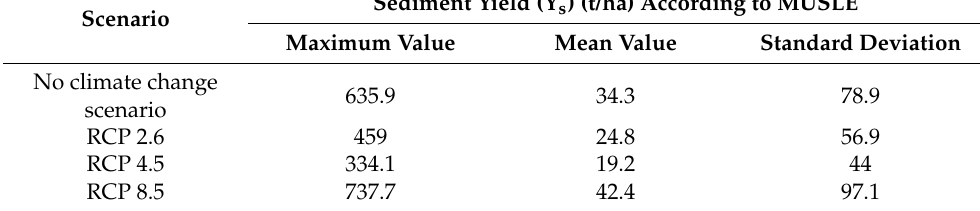
Table 8. Results of the statistical trend of the data obtained by the application of the MUSLE model (4 September 2011 rainfall event) to the Guerna catchment, considering different climate scenarios (where AMC II was used to generate surface runoff).